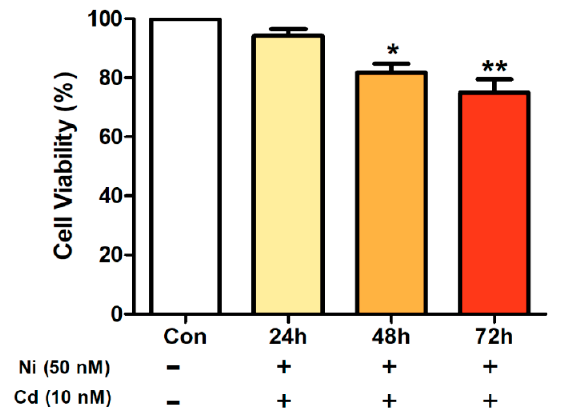
Figure 2. A594 lung cancer cell viability after treatment with a mixture of 50 nM of nickel (Ni), and 10 nM of cadmium (Cd). Bars represent means ± standard deviation. ** p < 0.01, * p < 0.05 vs. control.